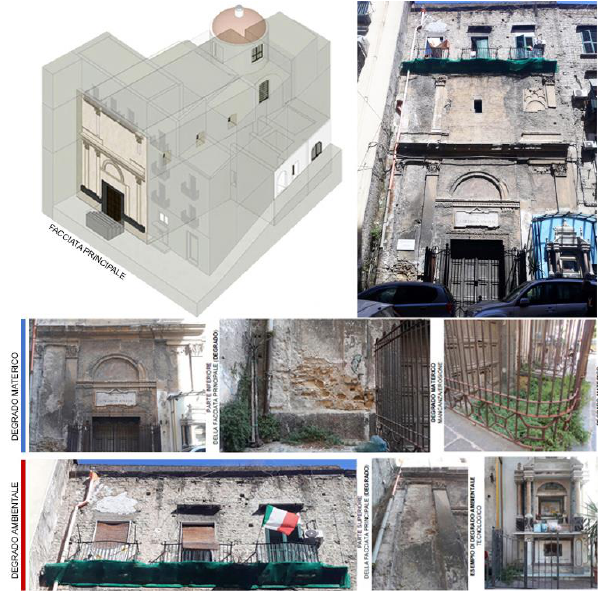
Figure 2 . Facade of Church of San Pietro in Vinculis , state of conservation.